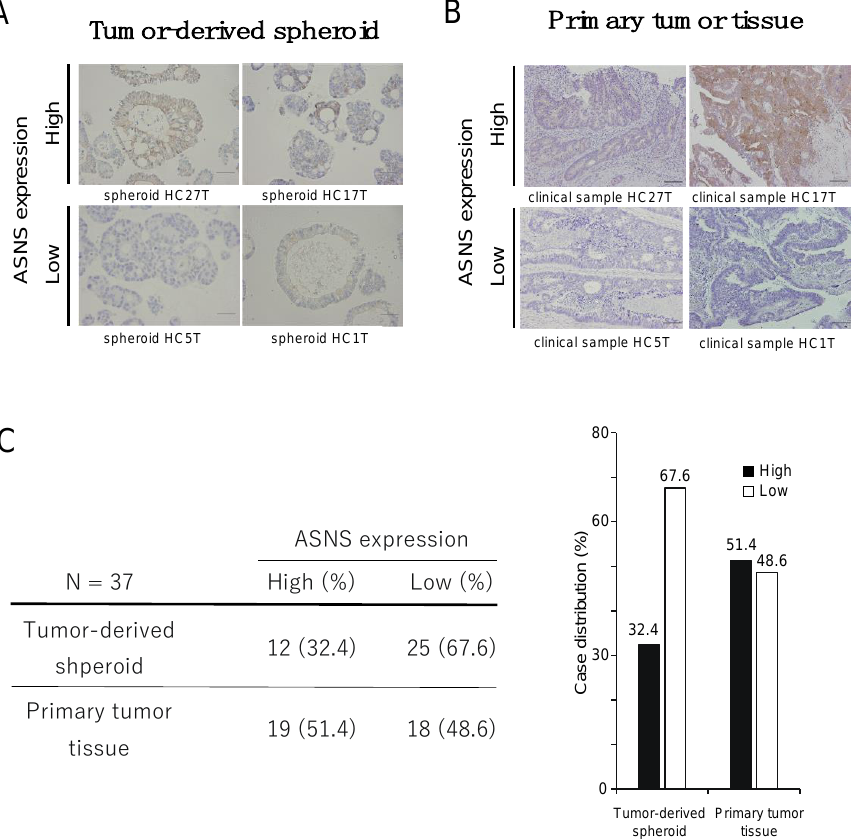
Figure 1. ASNS expression in CRC. ( A ) H&E staining for ASNS for tumor-derived spheroids. Scale bars, 100 µ m. ( B ) H&E staining for ASNS for primary CRC tissues. Scale bars, 100 µ m. ( C ) Status of ASNS expression. ASNS